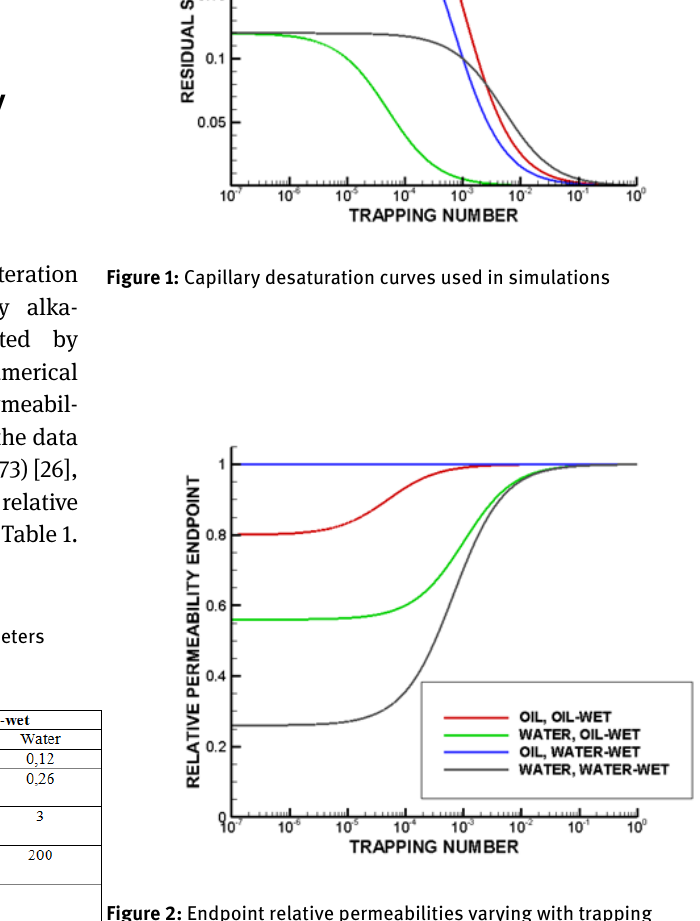
Figure 2: Endpoint relative permeabilities varying with trapping